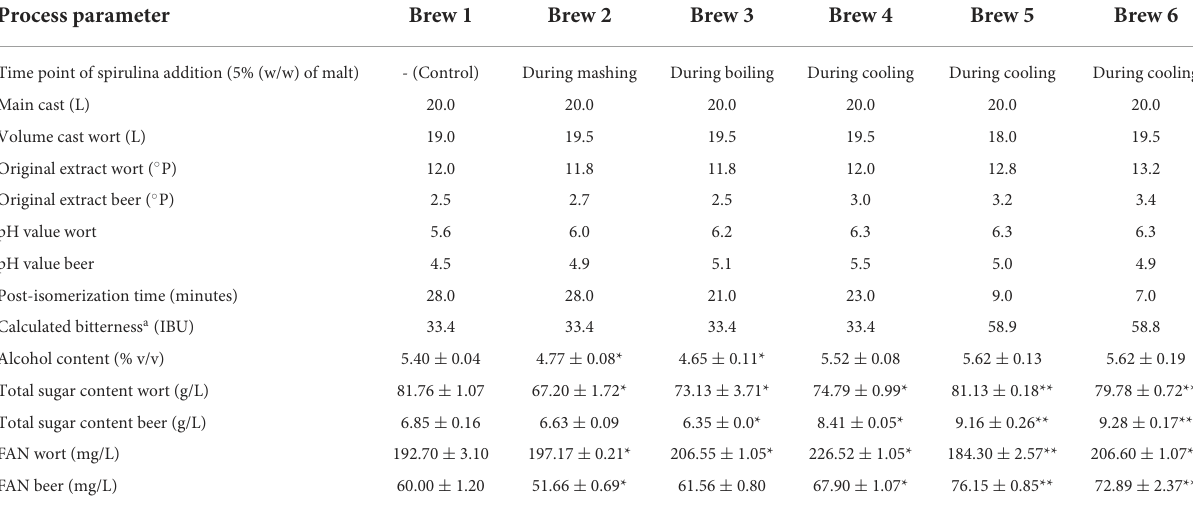
TABLE 2 Results of important process parameters and characteristics of the beers. Process